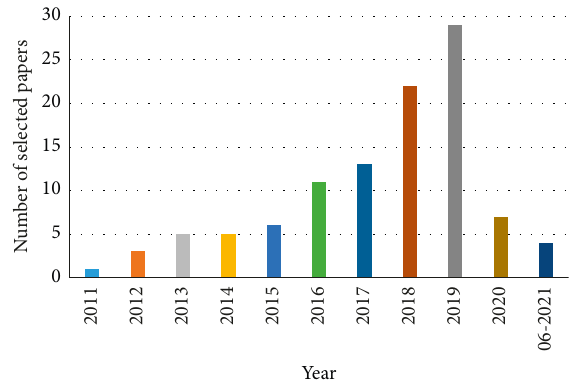
Figure 2: Statistics of the selected papers published per